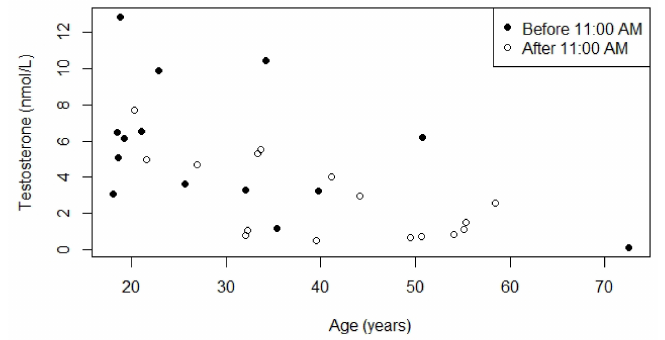
Figure 5. Relationship between serum testosterone concentrations and age for males who were not receiving testosterone replacement therapy. p -value for the relationship between age and serum testosterone concentration measured before 11:00 A.M. was 0.3, Kendall’s Tau was − 0.23. p -value for the relationship between age and serum testosterone concentration measured after 11:00 A.M. was 0.2, Kendall’s Tau was −